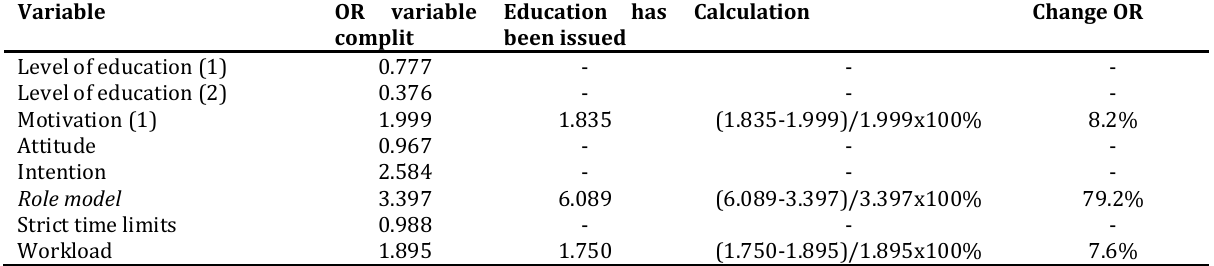
Table 6. Comparison of OR before and after the education level variable is excluded from the model of the relationship between the independent variables and the dependent variable on the handover implementation of nurses in the inpatient ward of Ulin Hospital